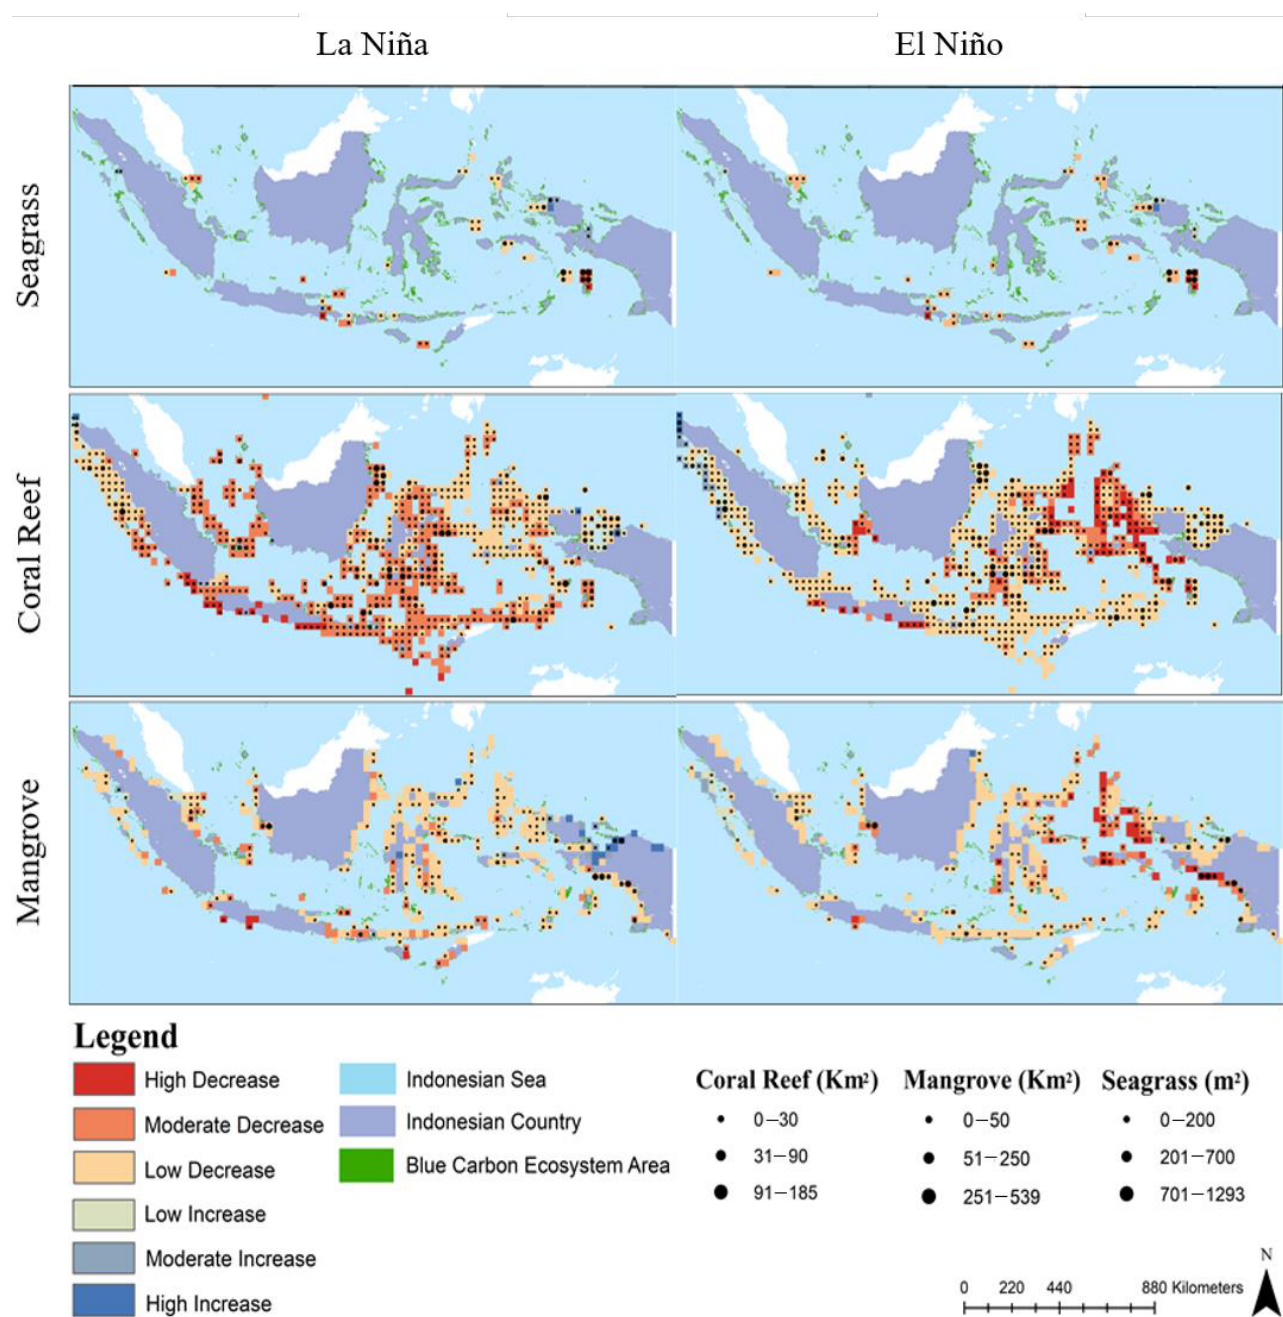
Figure 4. Changes in the average SST values in the Indonesian blue carbon ecosystem during the 2011 La Niña and 2015 El Niño years.